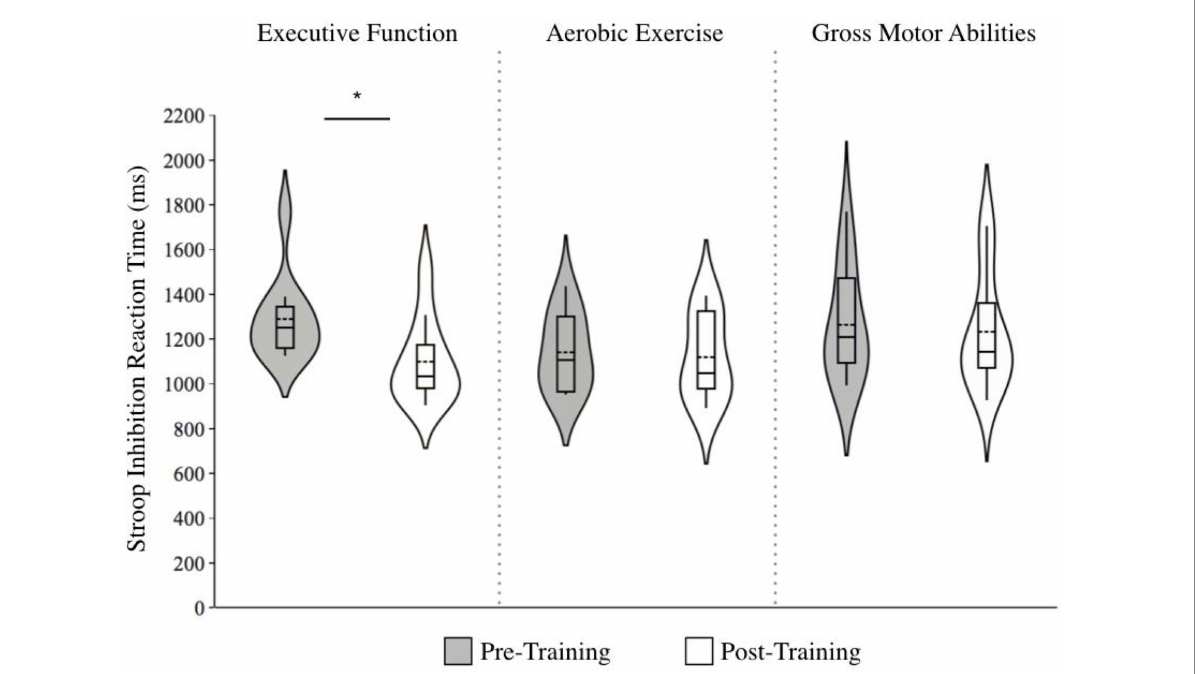
FIGURE 4 Violin plots of Stroop inhibition reaction times before and after training across training groups. Note. Lower scores indicate faster responses. The length of each curve represents the range of scores, the width represents the frequency of data points in each region, the solid line within each boxplot represents the median, and the dotted line represent the mean. There were significant improvements in reaction time for the executive function training group alone ( g = − 0.96 [large effect], ∆ = −